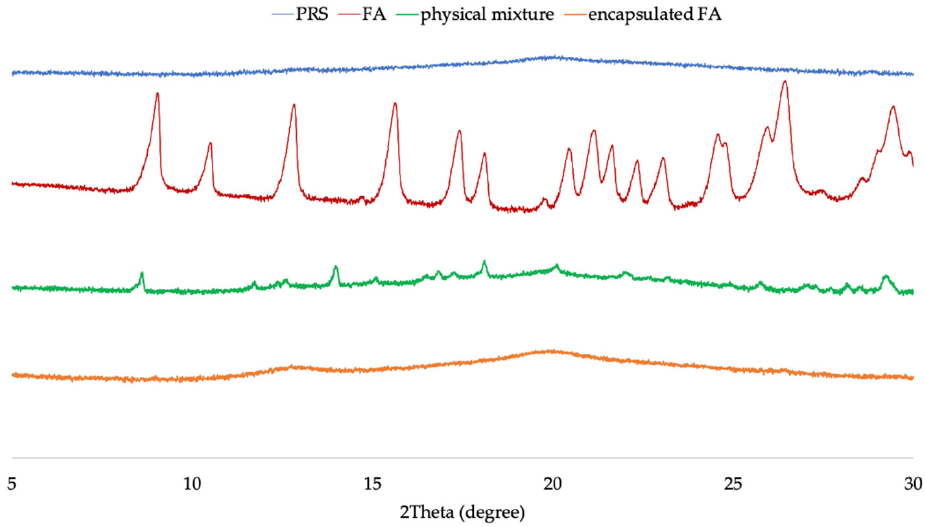
Figure 3. The X-ray diffractograms of PRS, FA, physical mixture, and encapsulated